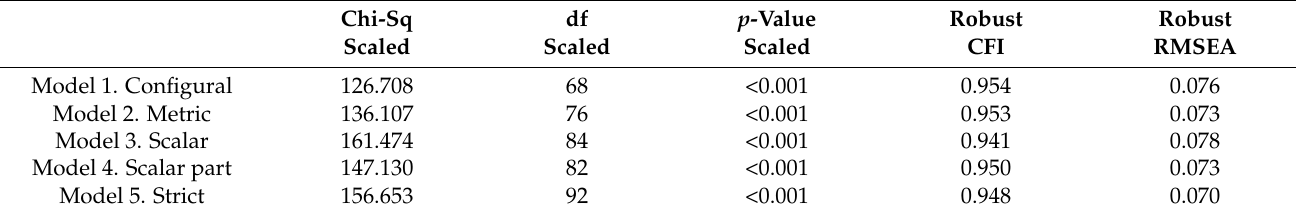
Table 2. Invariance for the GOEM scale split by gender.